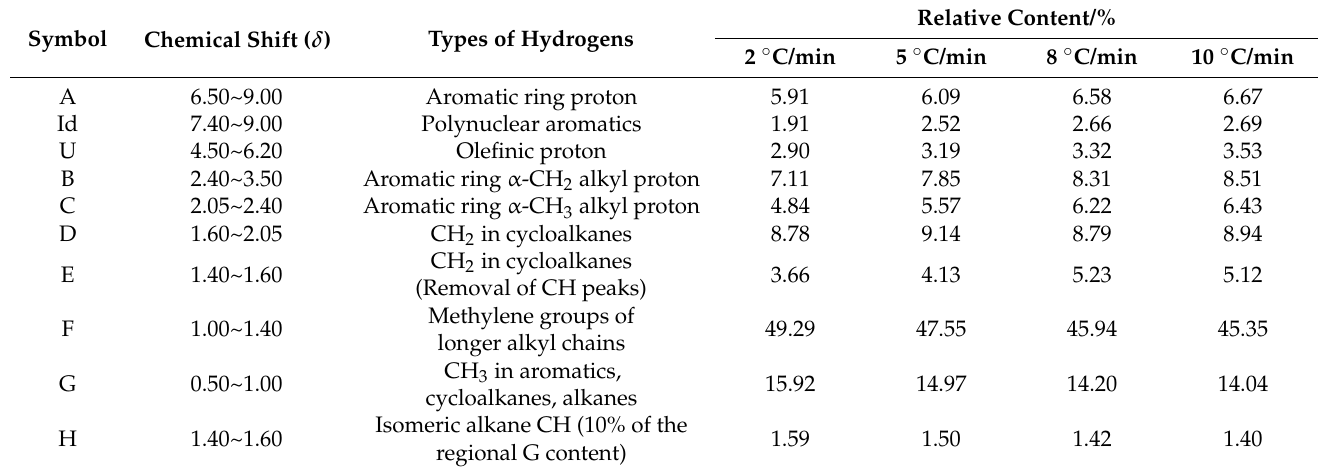
Table 7. Distribution of hydrogen of shale oil derived at different heating